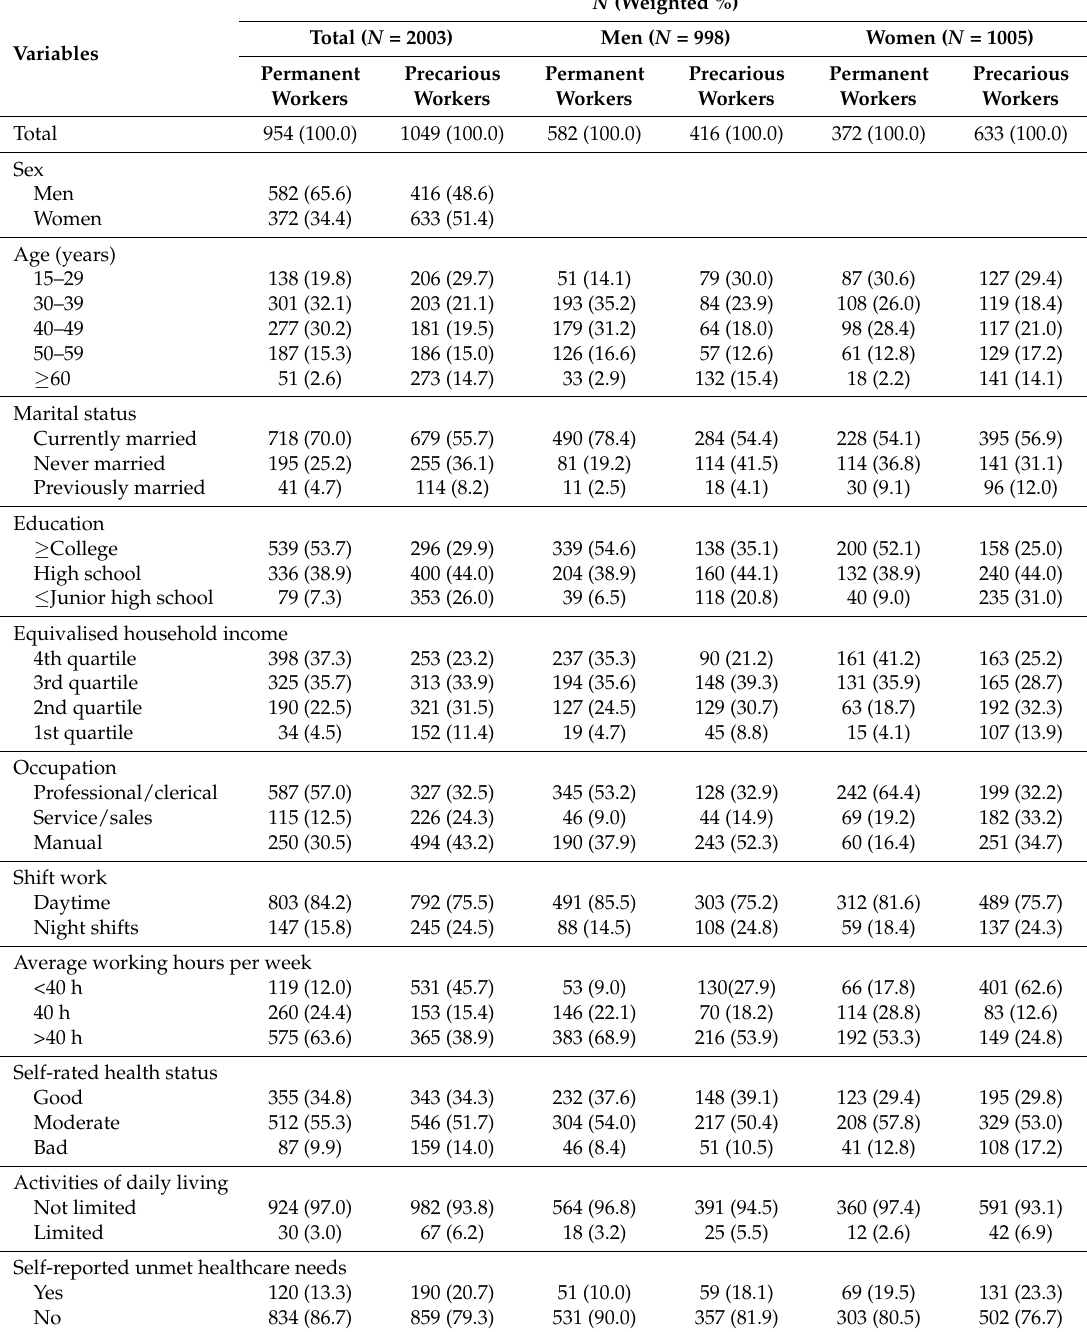
Table 1. Characteristics of study subjects by sex and employment